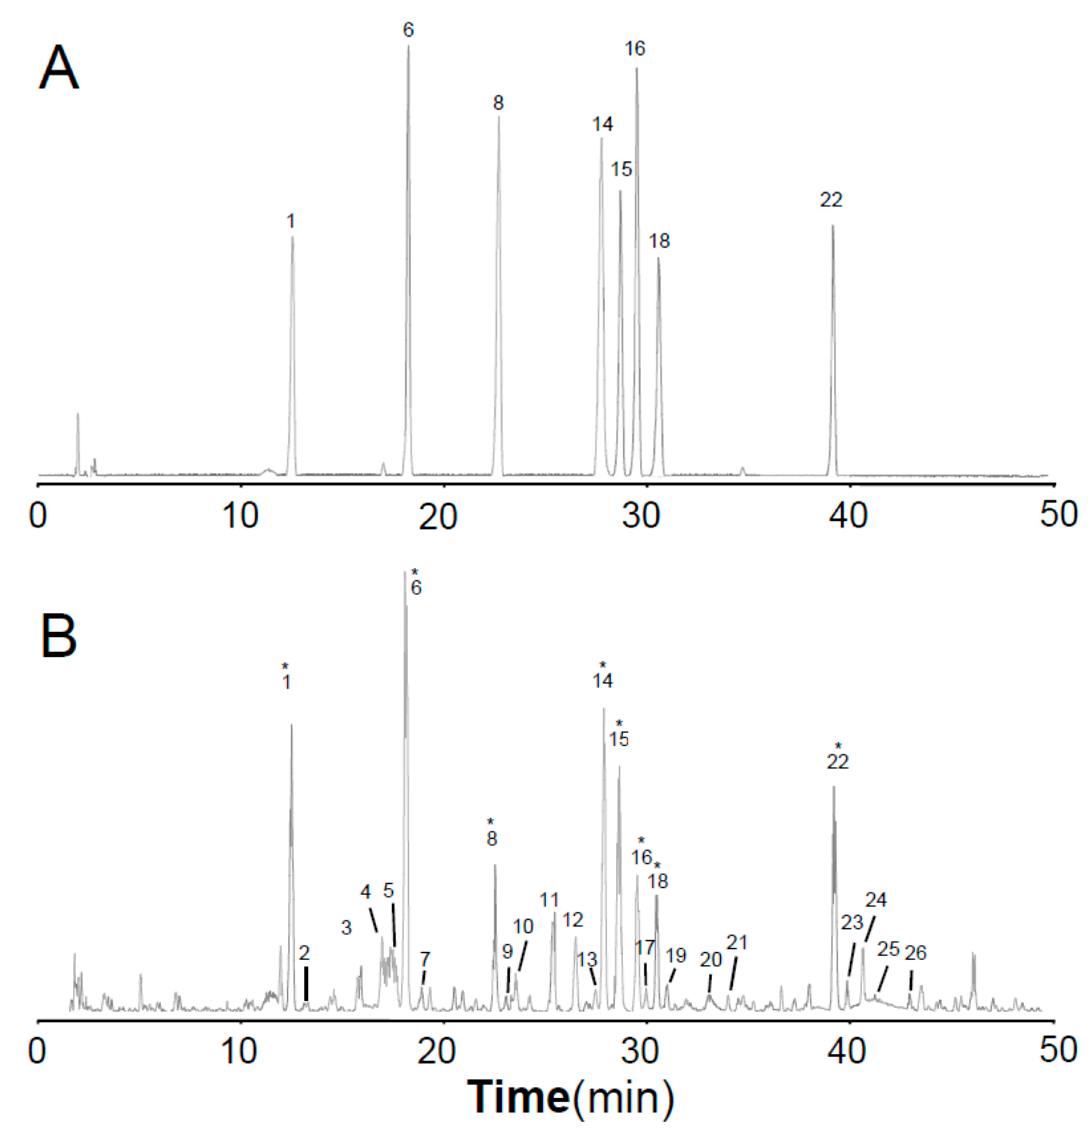
Figure 2. LC-QTOF / MS total ion current (TIC) profile of eight isoflavonoid references ( A ) and the extract of Astragali Radix ( B ) operated in positive mode. * These compounds were identified by their corresponding references.